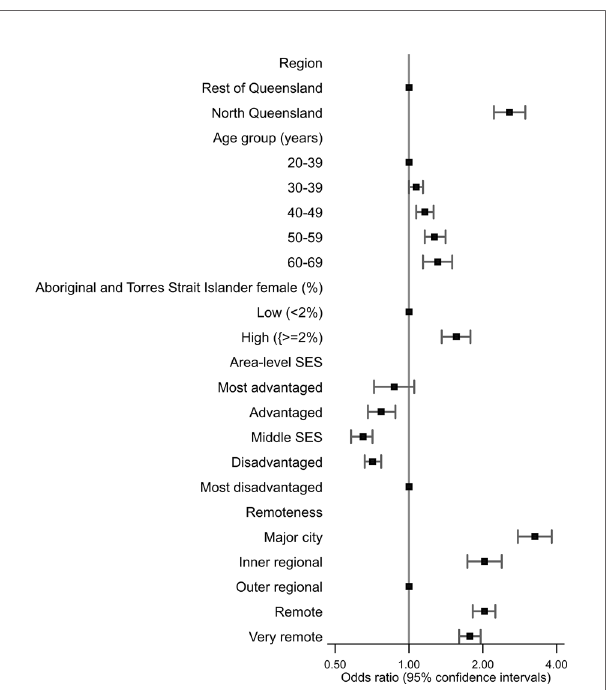
FIGURE 2 | Plot of odds ratios with 95% con fi dence intervals for factors associated with Aboriginal and Torres Strait Islander women attending